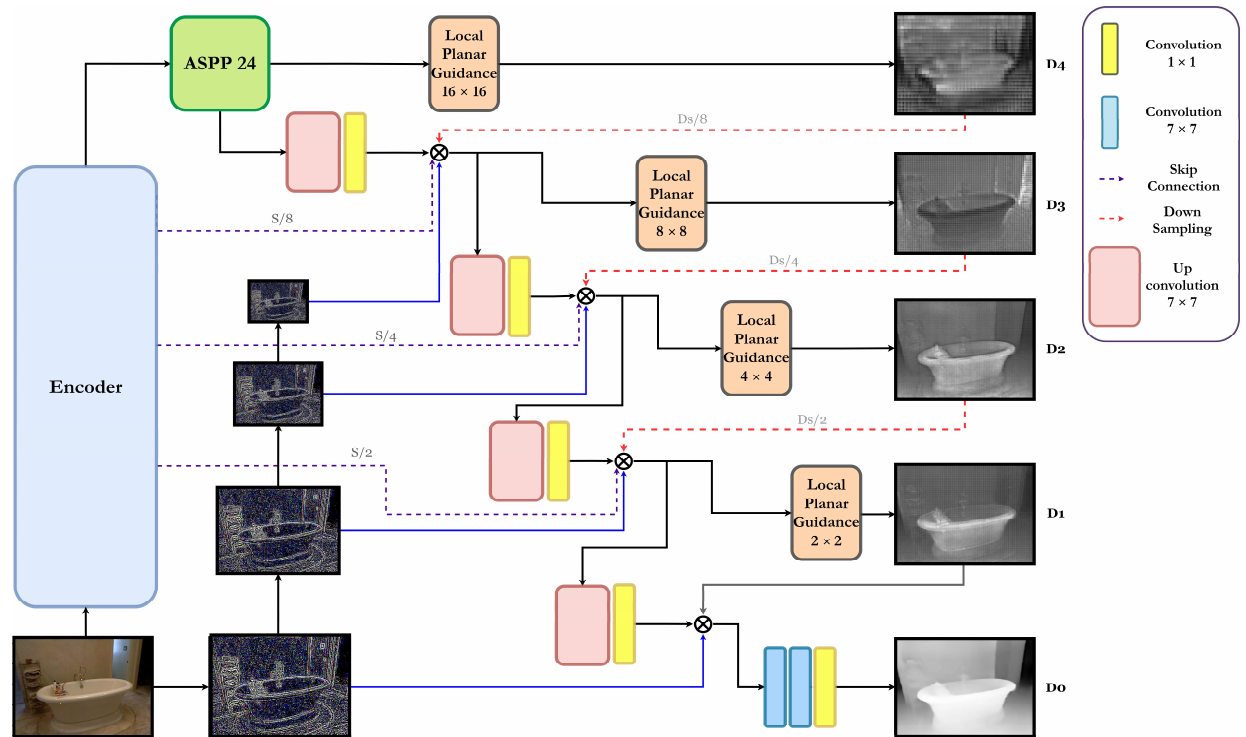
Figure 3. The proposed monocular depth estimation network architecture.